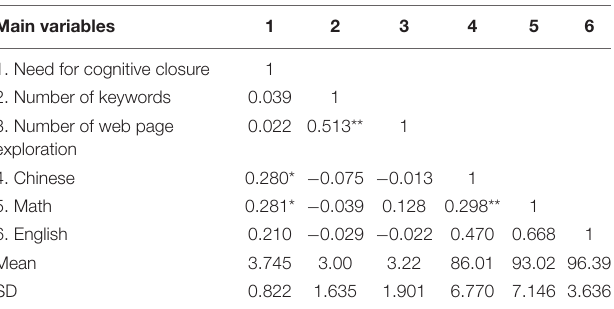
TABLE 1 | Correlations.